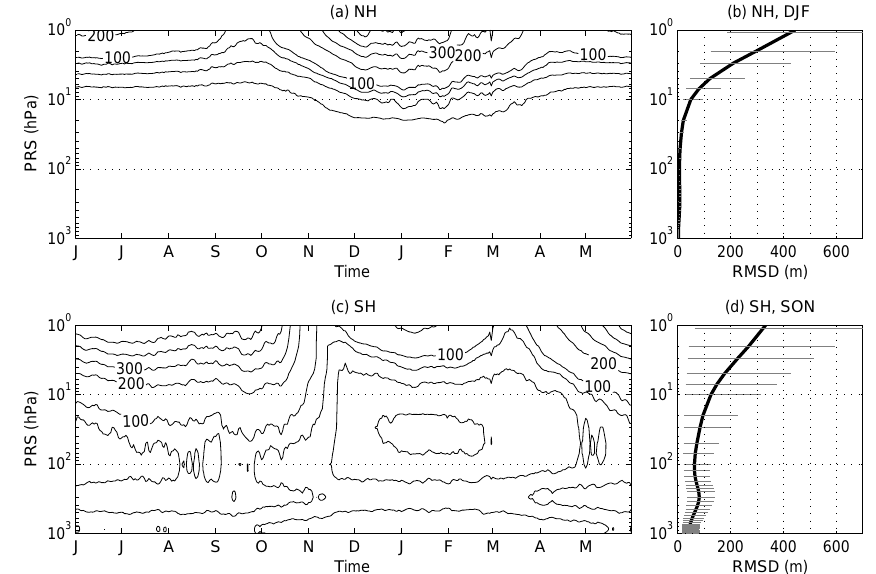
Figure 6. (a, c) Time–height sections of the climatology of RMSD: (a) NH and (c) SH. The contour interval is 100m, with additional contours at 25, 50, and 75m. Panels (b, d) plot seasonal means as a function of height: (b) NH for DJF and (d) SH for SON. The horizontal lines denote 5th and 95th percentiles.